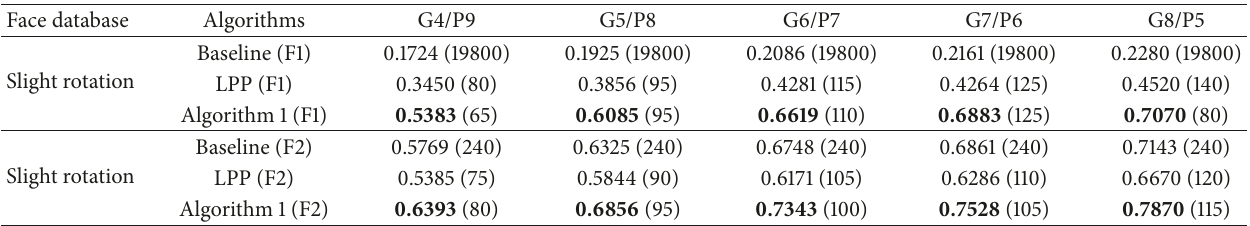
Table 9: The recognition rates on slight rotation AR face database over “F1” and “F2” features; recognition rates (dimensionality).